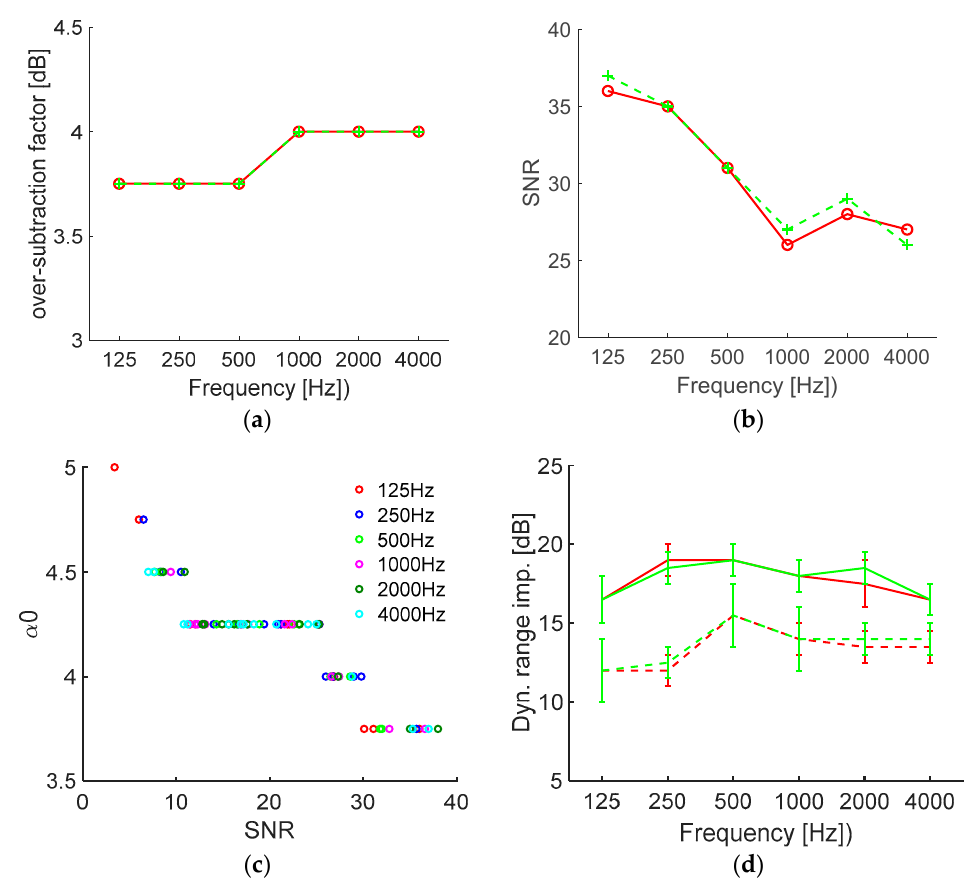
Figure 7. Results of the optimal α 0 for different SNRs of three filtered RIRs in octave bands with two types of noise and various noise levels ( − 65 dB to − 40 dB estimated in broadband RIRs). ( a , b ) Optimal α 0 for RIRs with noise levels − 60 dB and corresponding SNRs. ( c ) Relationship of the optimal α 0 and SNR. ( d ) Dynamic range